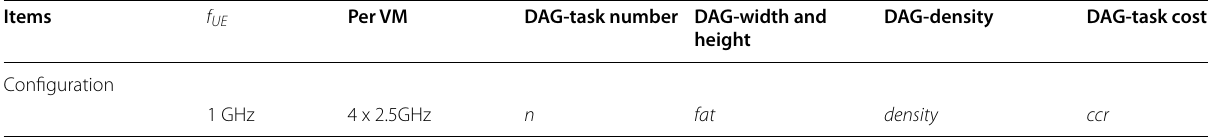
Table 3 Simulation set up: We generate synthetic DAG according to [49], whose model is characterised by: n , fat , density , and ccr , where n represents the task number, fat controls the width and height of the DAG, density decides the number of edges between two levels of the DAG, and ccr denotes the ratio between the communication and computation cost of tasks